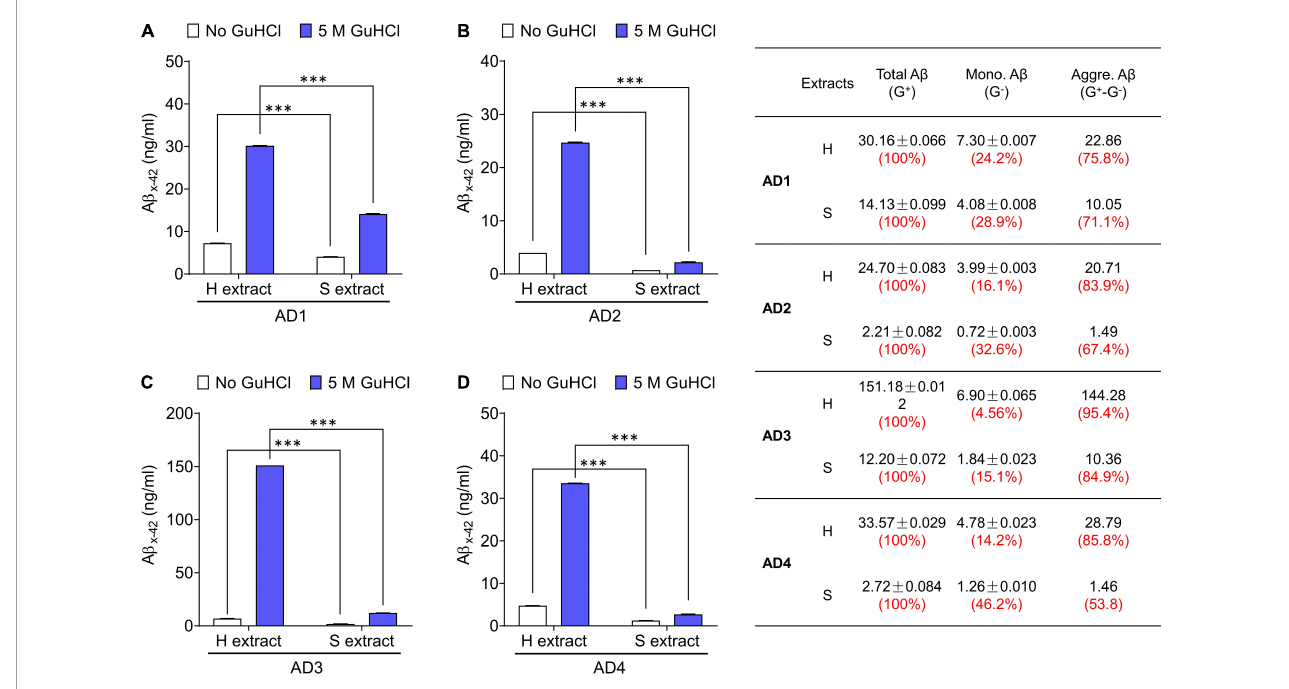
FIGURE1 Aqueous extracts of AD brains contain a mixture of A β monomers and soluble aggregates. (A–D) The MSD-immunoassay preferentially detects monomeric A β x-42. H extracts and S extracts from four AD brains were assessed for A β content with and without pre-incubation in 5 M GuHCl. A β measured without incubation in GuHCl is attributed to A β monomer, whereas A β detected in the homogenate pre-treated with GuHCl is the product of A β aggregates dissociated to monomer, plus native monomer. The table indicates the relative amount of A β present as native monomer and A β in aggregates dissociable with 5 M GuHCl. G– and G+ denote no GuHCl and 5 M GuHCl, respectively. Values were shown as mean ± SD. Treatments were examined by one-way ANOVA and significant differences are denoted as ∗∗∗ p <